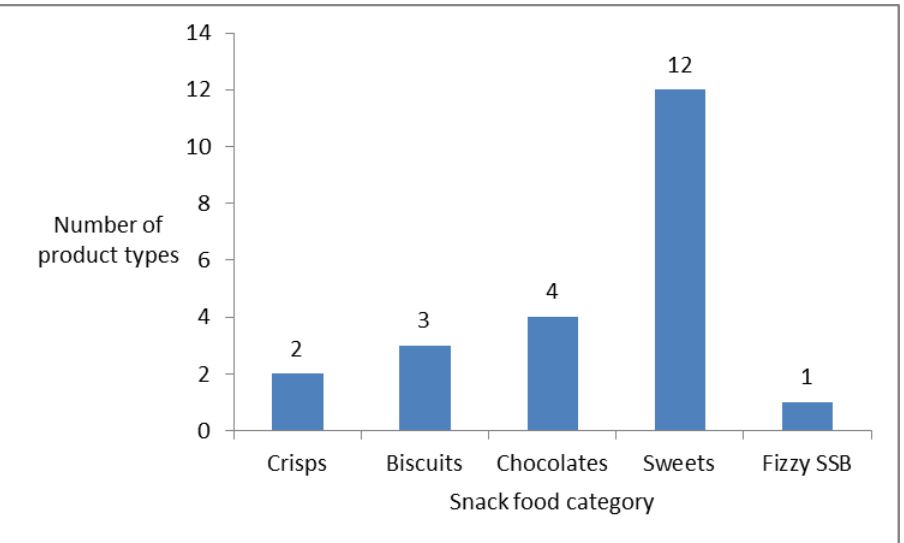
Figure 2. Total number of product types available for each snack food category at the school tuckshop in the study school.